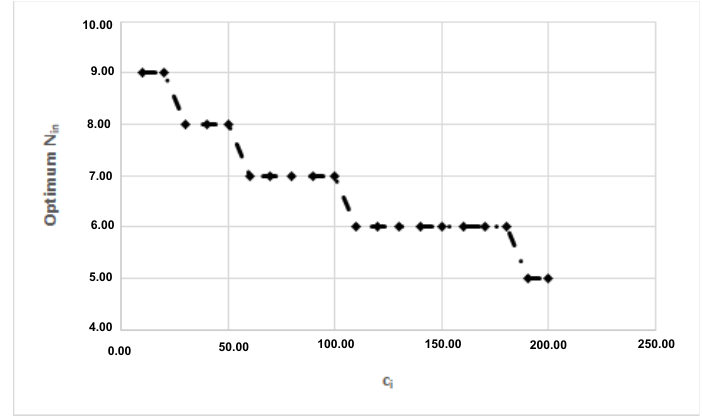
Figure 10. Variations of optimum N in per c i .